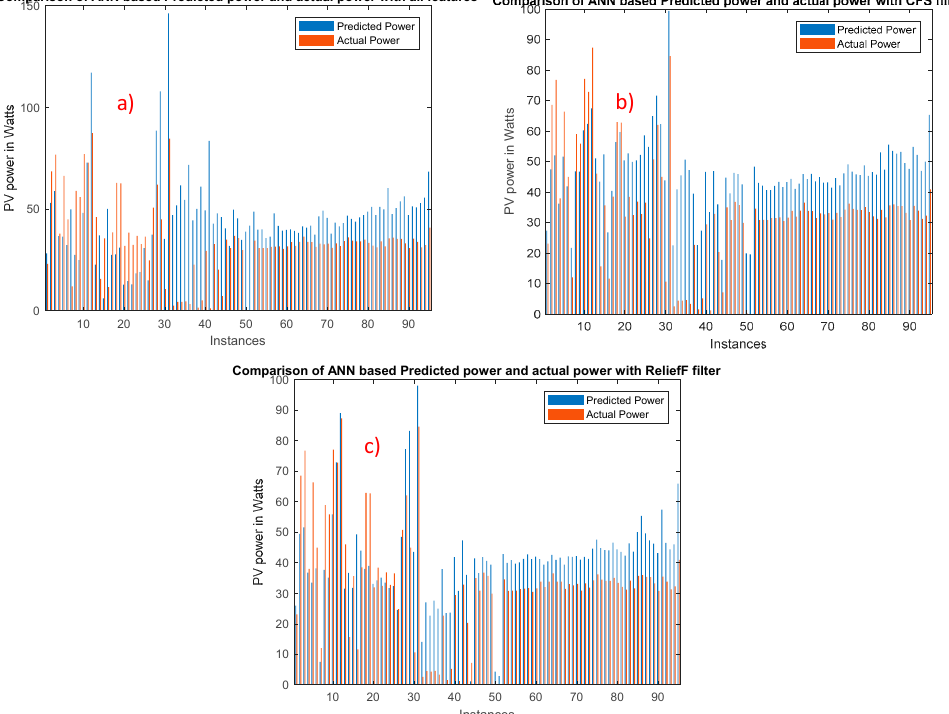
Figure 8. Comparison of the ANN predicted power with the actual power using test dataset: ( a ) With all features; ( b ) CFS feature selection technique; ( c ) ReliefF feature selection technique. Table 7. (A) Performance comparison between the various ANN techniques (validation phase). (B) Performance comparison between the various ANN techniques (testing phase).